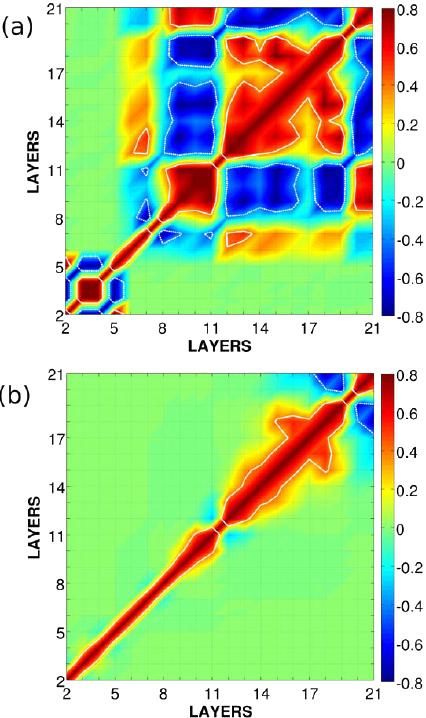
Figure 3. Vertical correlations of layer thickness between different layers at the location of an Argo float (69.95 ◦ W and 30.14 ◦ N) in the model domain: (a) calculated directly from the model ensembles ( M = 132) and (b) after applying the vertical localization of layer thickness according to Eq. (5) and L ρ defined as 0.5kgm − 3 . The white lines denote correlations above 0.4 and below − 0 .